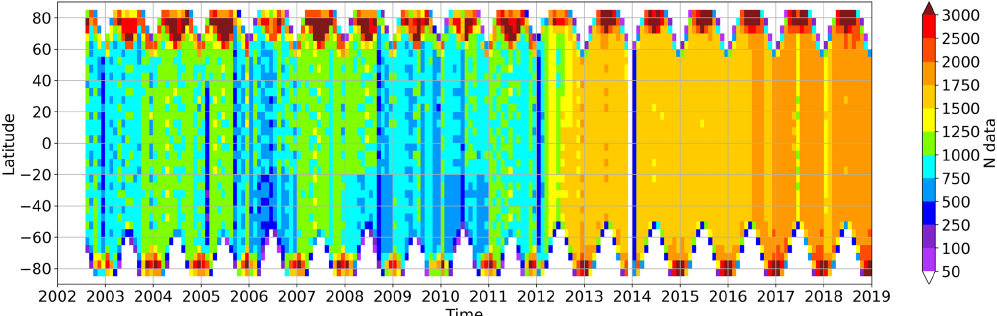
Figure 1. Number of SCIAMACHY and OMPS-LP observations as a function of time and latitude in each 5 ◦ zonal monthly bin.